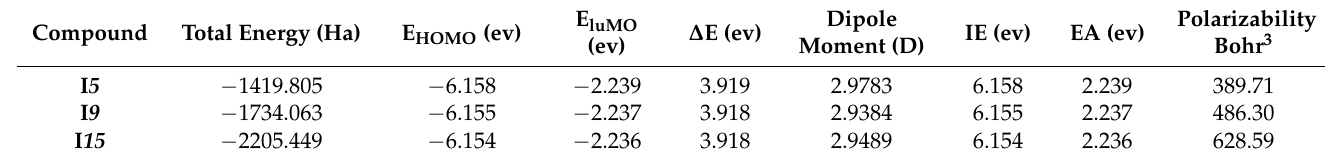
Figure 5. FMO’s estimated for the synthesized I n set. Table 3. Thermal energy parameters for the investigated I n set.